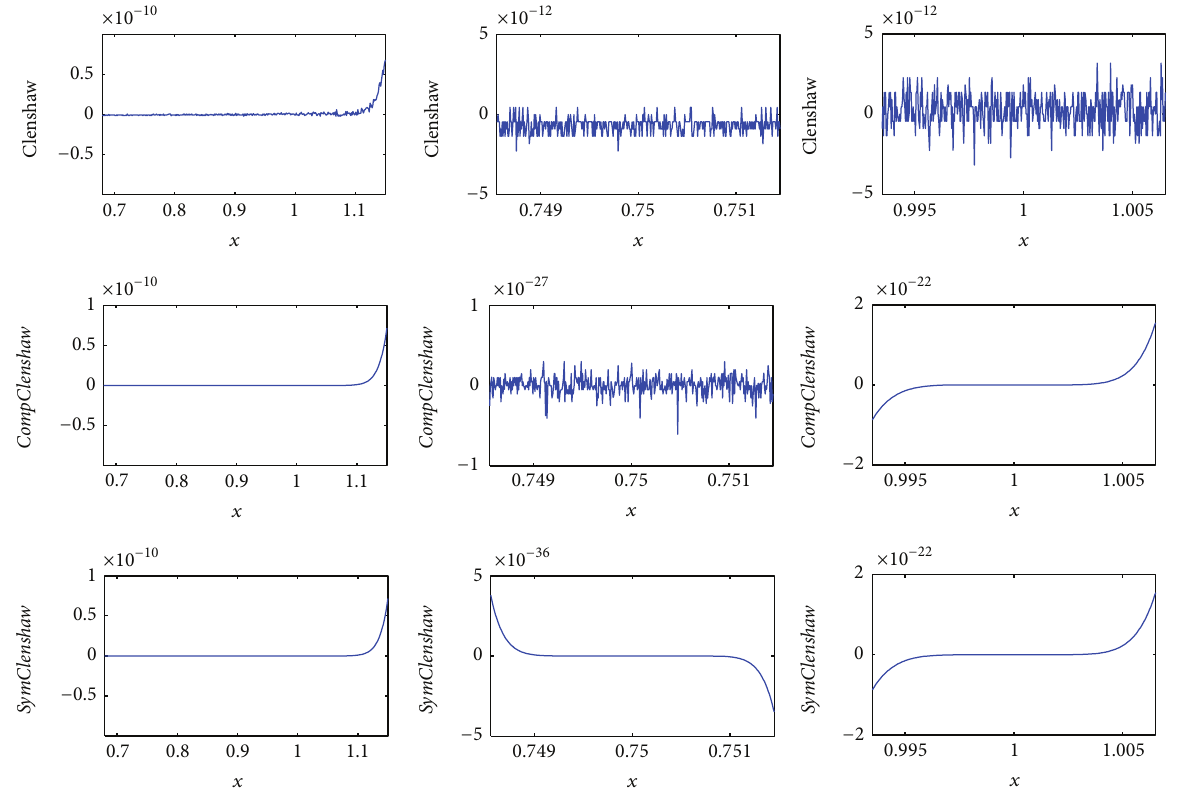
Figure 2: Evaluation of polynomial converted from 𝑝(𝑥) = (𝑥 − 0.75) 7 (𝑥 − 1) 11 by the 𝐷𝐷𝐶𝑜𝑛 V 𝑒𝑟𝑡 algorithm in Legendre basis in the neighborhood of its multiple roots, using the Clenshaw algorithm (up), the 𝐶𝑜𝑚𝑝𝐶𝑙𝑒𝑛𝑠ℎ𝑎𝑤 algorithm (middle), and Symbolic Toolbox